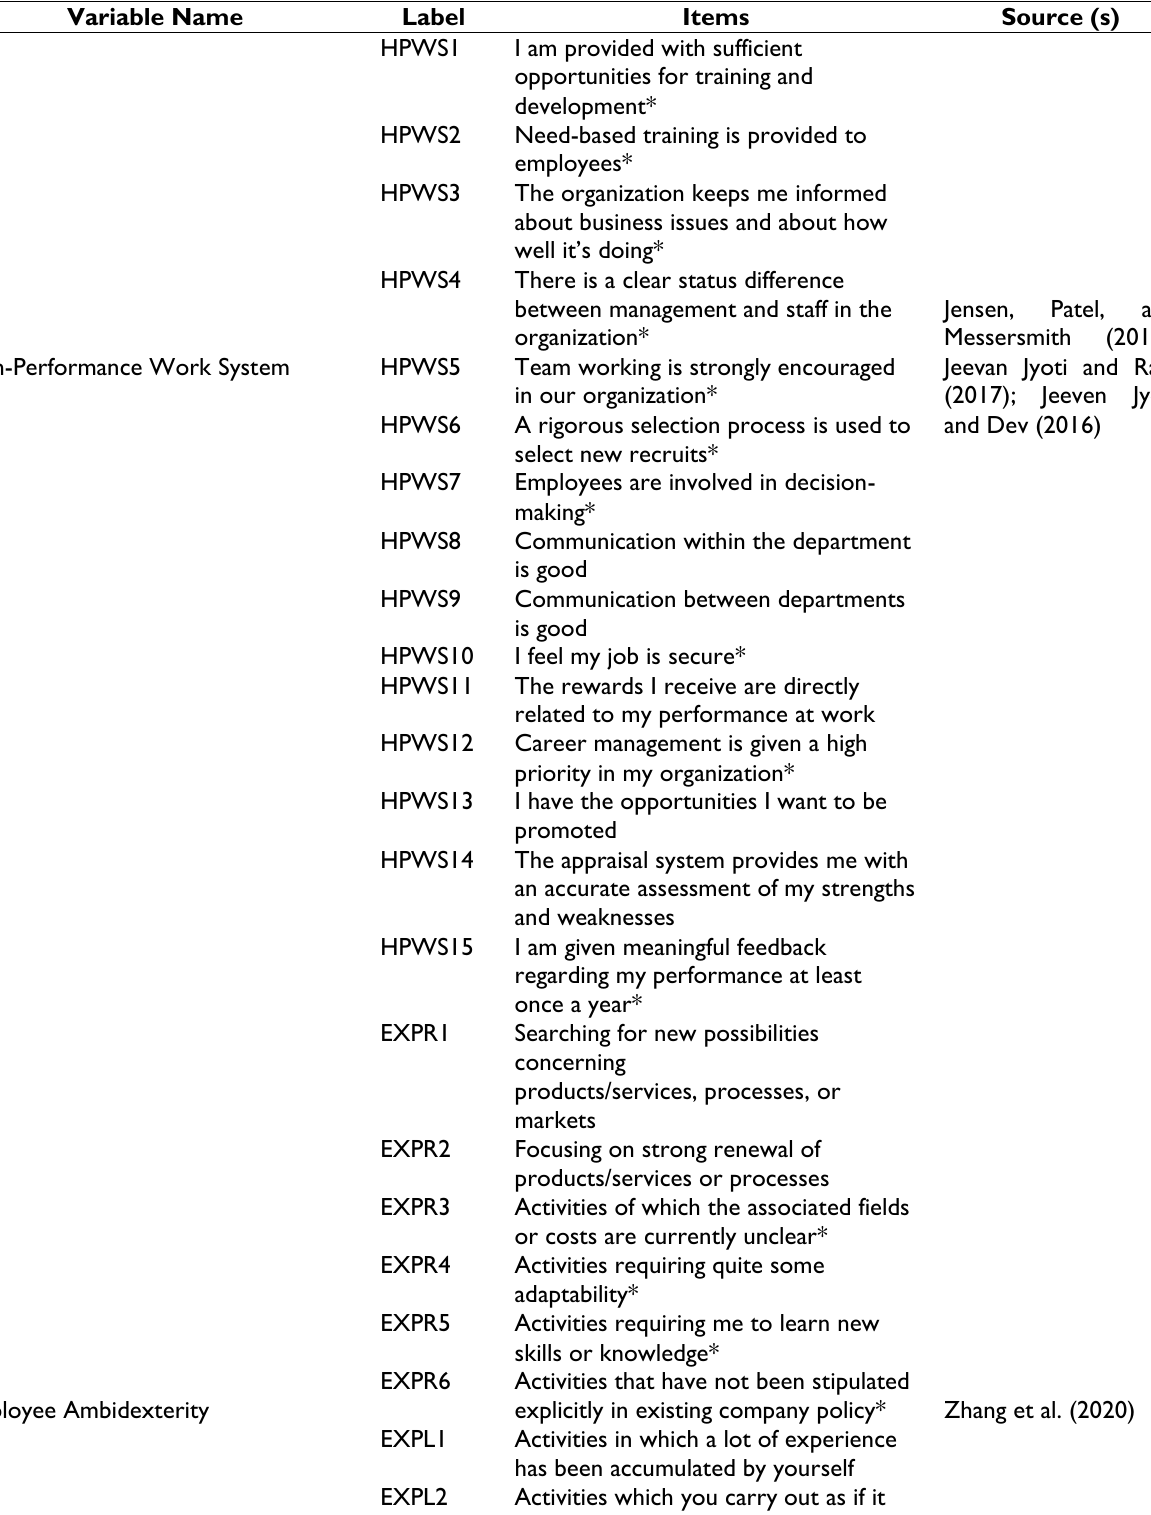
Table 1. Research